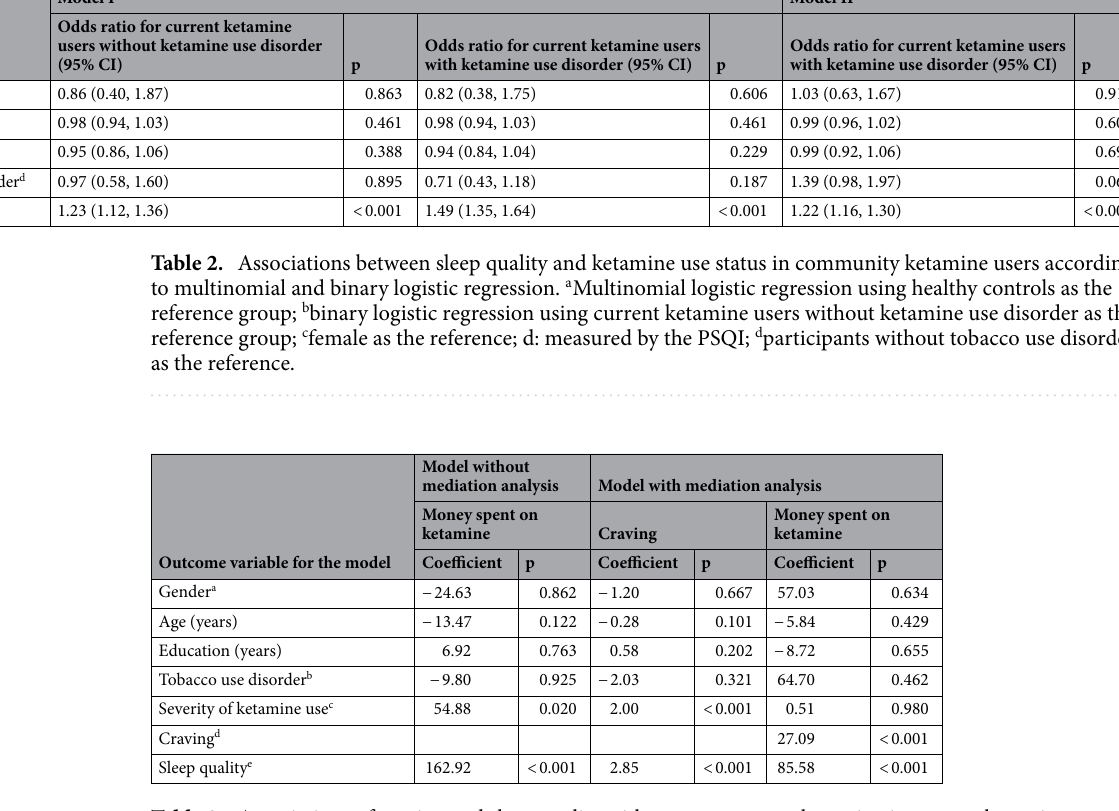
Table 3. Associations of craving and sleep quality with money spent on ketamine in current ketamine users with ketamine use disorder. a Female as the reference; b no tobacco use disorder as the reference; c measured by the SDS; d measured by the VACS; e measured by the